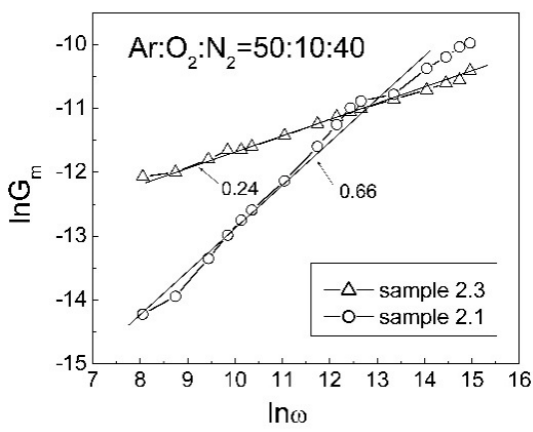
Figure 7. Logarithm of AC conductance, G m , versus logarithm of angular frequency, ω , of MIS structures with ZnO:N films deposited at Ar:O 2 :N 2 = 50:10:40 (sample 2.1) and after RTA at 550 °C (sample 2.3).